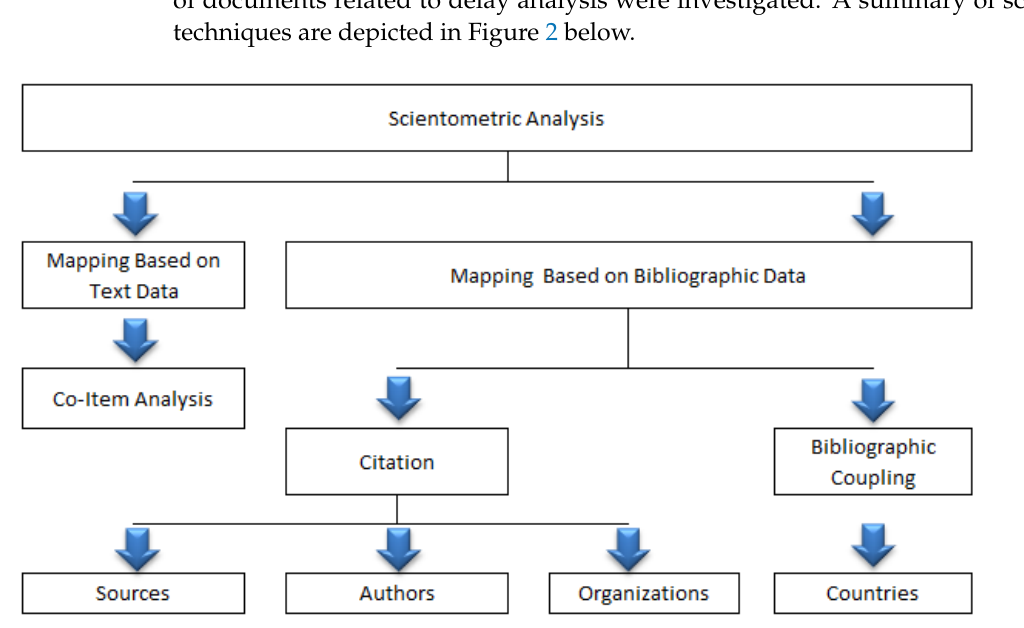
Figure 2. Summary of scientometric techniques.